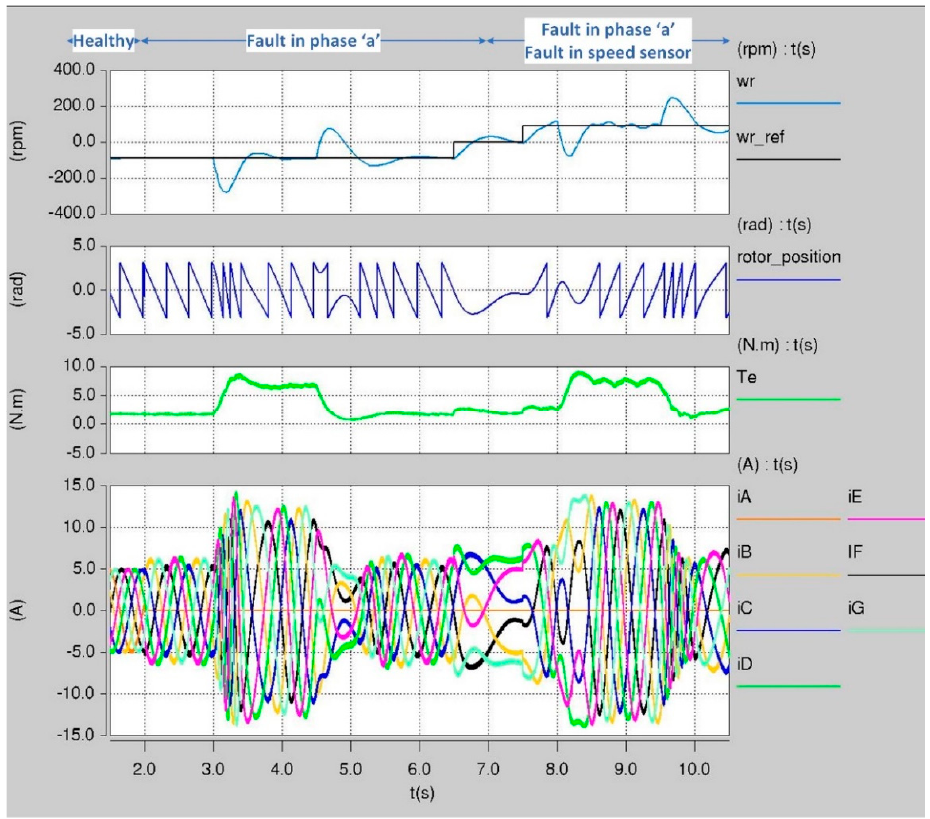
Figure 21. Load steps post the failures in speed sensor and in phase ‘A’ of the seven-phase motor drive.